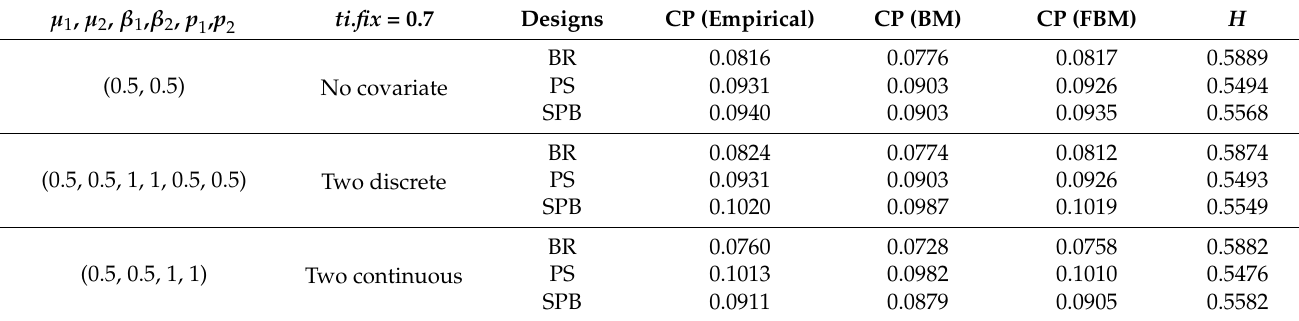
Table 3. CPs under misspecification scenarios: ε ’s ~increments of FBM, H = 0.9, drift = 0.5. , p µ 1 , µ 2 , β 1 , β 2 , p 1